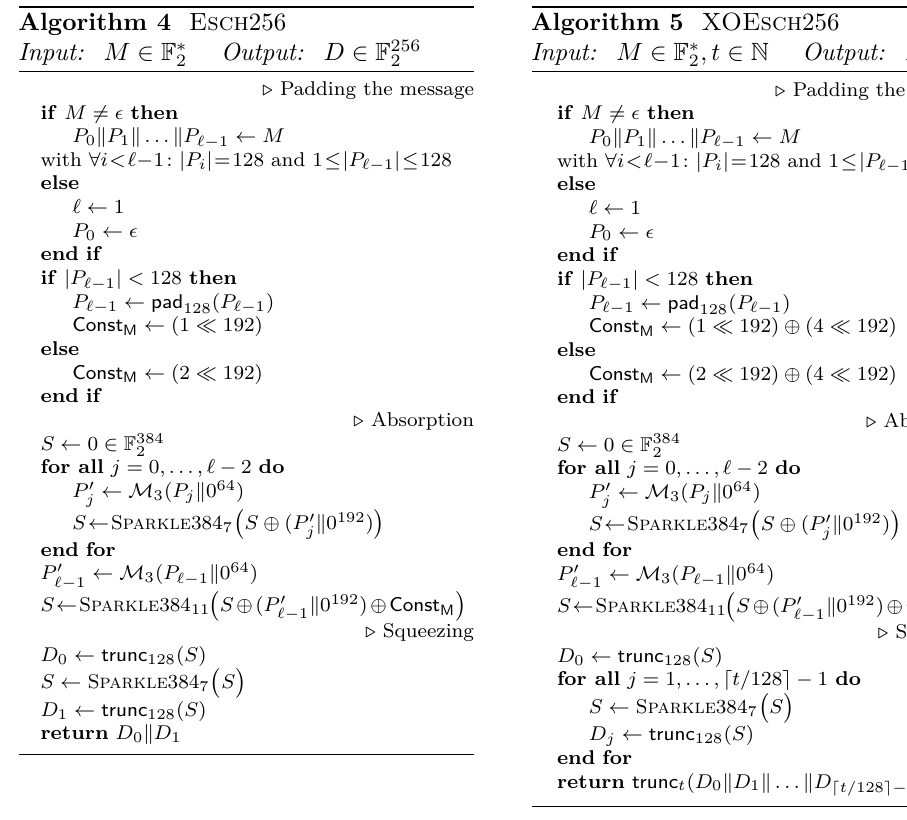
Lightweight AEAD and Hashing using the Sparkle Permutation Family